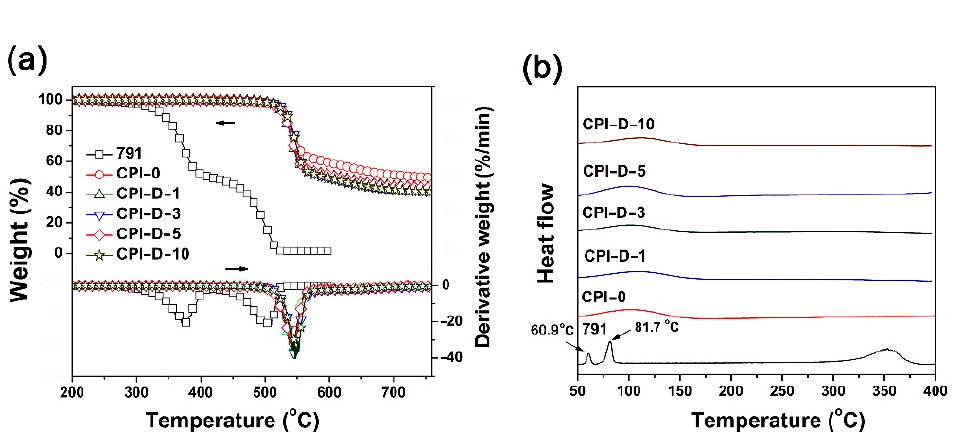
Figure 13. Thermal properties of CPI-0 film and CPI/791 nanocomposite films under nitrogen flow. ( a ) TGA and DTG; ( b ) DSC. Table 6. Thermal properties of the CPI-0 film and CPI/791 nanocomposite films.